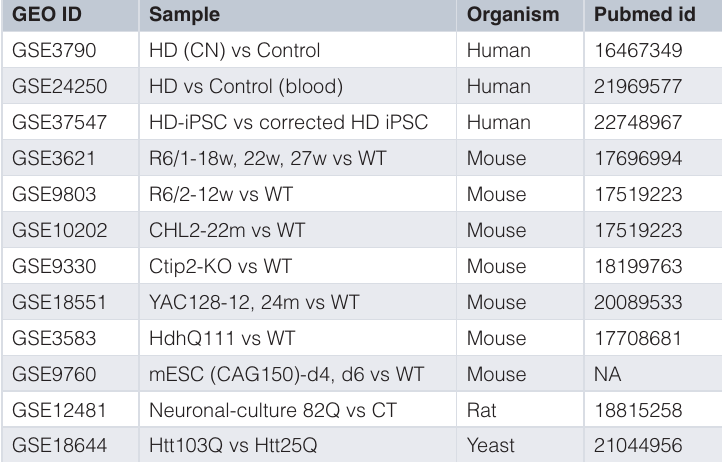
Table 2. List of HD gene expression datasets used for the gene set enrichment analysis.